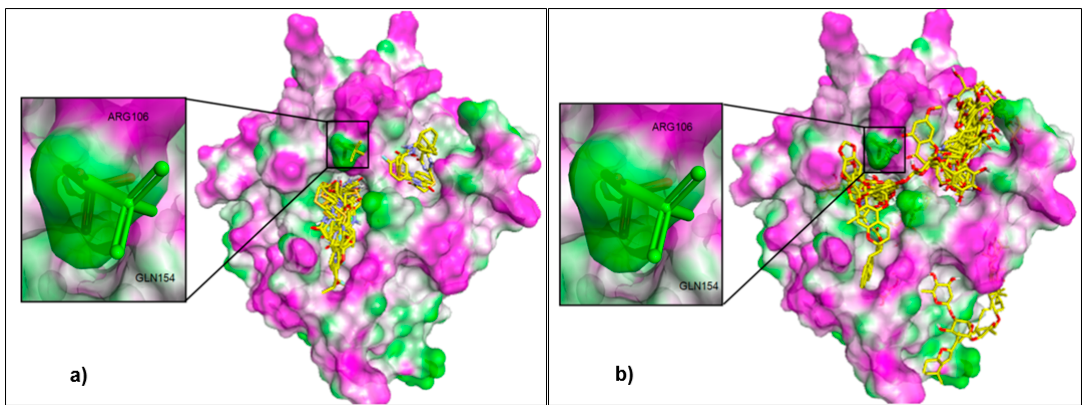
Figure 2. Superimposition of ( a ) 17 published PEX9 inhibitor and ( b ) top twenty ligand scores docked into PEX9 with deep pocket in the left side and shallow pocket in the right side. Inset is the control docking of sulfate ion with green stick is initiate pose and red stick is re-docked pose. The external ligands are colored in stick model with C = yellow; H = white; O = red; and N = blue. The protein is presented in a surfaced form with magenta area = hydrogen bond donor; white = neutral and green = hydrogen bond acceptor.